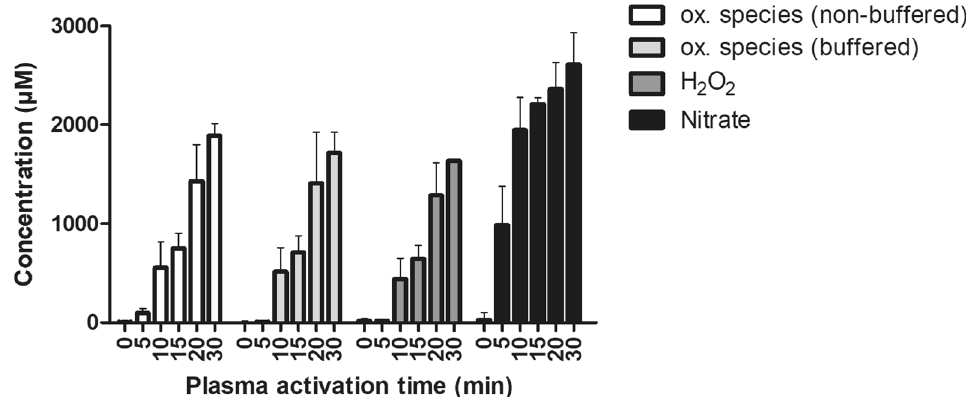
Figure 2. Chemical composition of PAS after exposure to spark plasma discharge for activation times of 0–30 min. Oxidative species refer to species able to oxidize potassium iodide (KI) at acidic pH (non-buffered) or neutral pH (buffered). The results are the mean ± S.D. of three